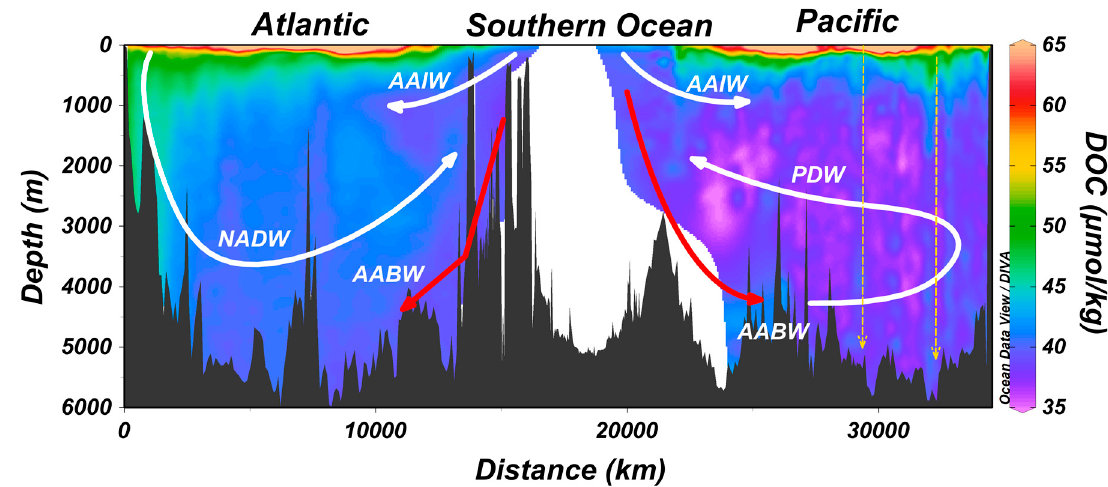
Figure 1. Vertical distribution of DOC ( µ molC/kg) along ocean sections A16 and P16 in the Atlantic and Pacific Oceans, respectively (locations given in Figure 2). Data density is low in the Southern Ocean along the section connecting the southern termini of A16 and P16, hence the gap in coverage. Solid arrows schematically indicate the major overturning circulation pathways in the ocean, specifically NADW, AABW, AAIW, and PDW. The dashed arrows represent the apparent pathways of sinking biogenic particles (exported from the surface ocean) that disaggregate while sinking, in turn adding DOC to the deep-water column. This enrichment serves as a substrate to heterotrophs (including prokaryotes) living in the greatest depths of the ocean. Note the vertical alignments of DOC enrichment adjacent to those arrows due to the disaggregation and solubilization of particles. NADW = North Atlantic Deep Water; AABW = Antarctic Bottom Water; AAIW = Antarctic Intermediate Water; PDW = Pacific Deep Water.